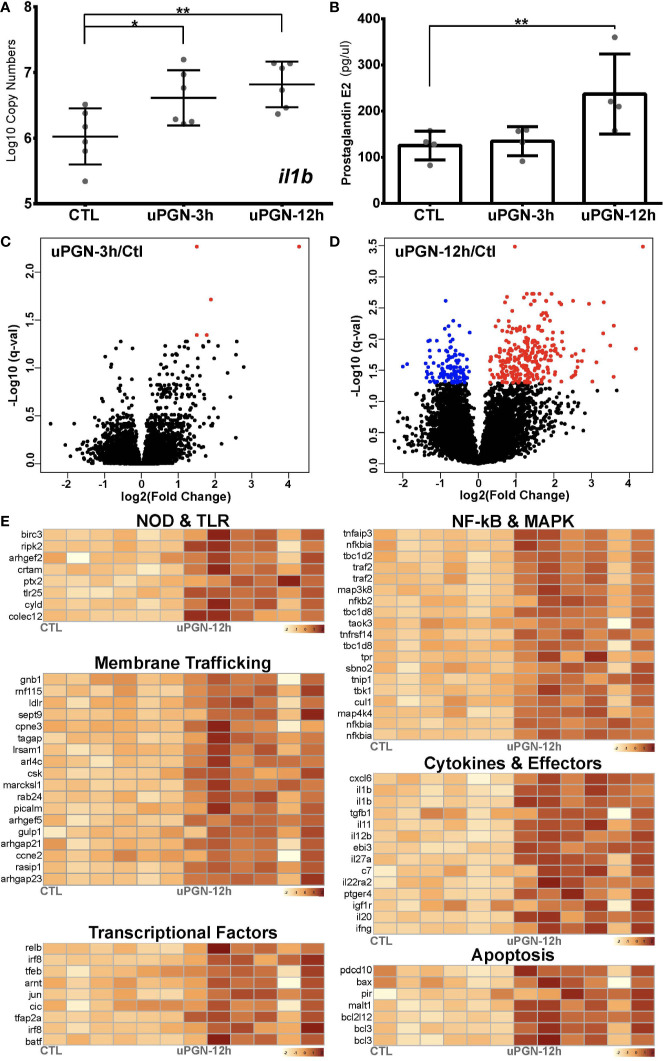
Antibacterial response to uPGN challenge (A, B). Immune response to uPGN measured by (A) copy number (log10) of il1b and (B) prostaglandin E2 secretion in ex-vivo cultured cod macrophages (C, D). Volcano plots of the expression patterns and statistical significance (red if significantly up-regulated, blue if significantly down-regulated, FDR < 0.05) of genes across six biological samples challenged with uPGN for (C) 3 h and (D) 12 h contrasted with control samples (E). Transcript abundance (log10FPKM+1) of selected DEGs challenged with uPGN for 12 h. Grouped based on shared signaling pathways.